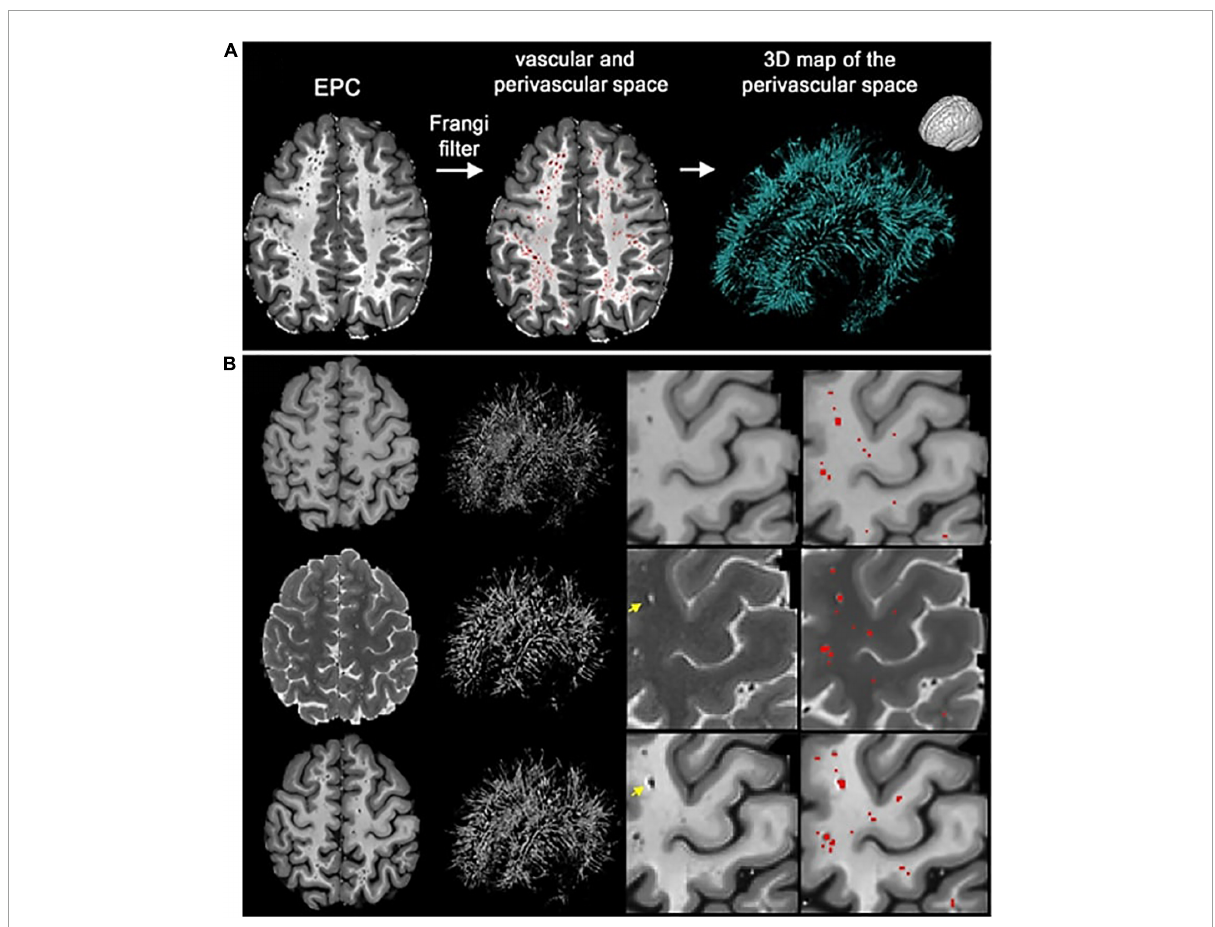
FIGURE8 The enhanced perivascular contrast (EPC) pipeline proposed by Sepehrband et al. (2019). In EPC, a T1-weighted image is combined with a co-registered T2-weighted image to improve the visibility of PVS. (A) Subsequently, non-local means filtering is applied and PVS are automatically segmented by a Frangi filter. (B) Comparisons between Frangi filtered PVS from a lone T1 image (top), a lone T2 image (middle), and combined modalities in EPC (bottom). Segmented voxels are labeled in red. Reproduced under the Creative Commons Attribution 4.0 International License